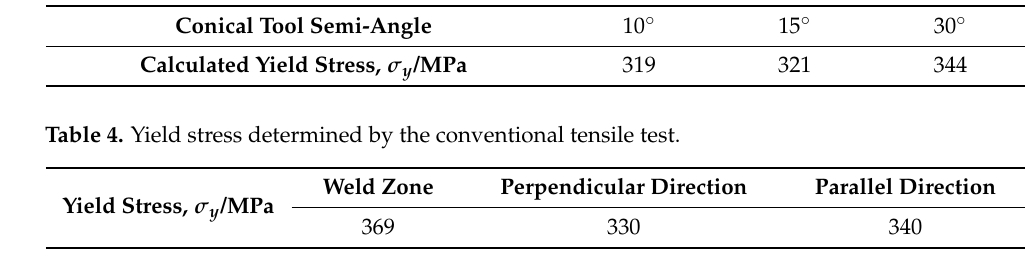
Table 3. Calculated results of yield stress with the flaring tests with different conical tools.